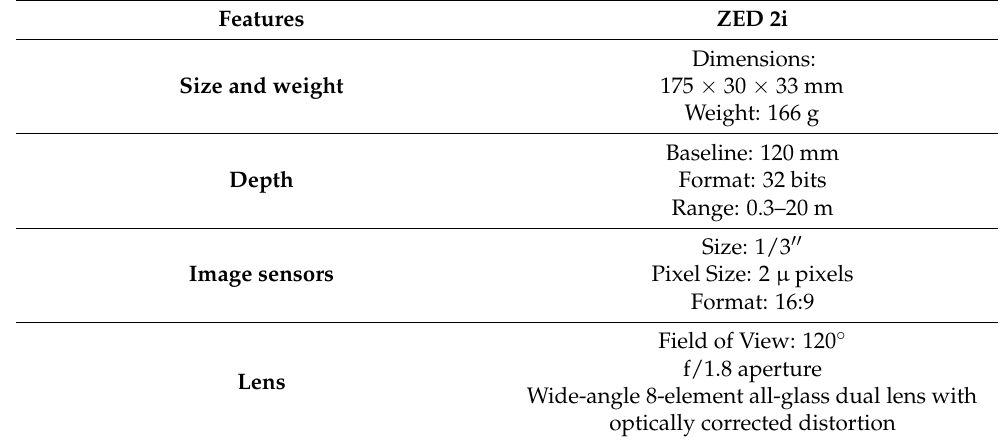
Table 2. Features of ZED 2i depth sensor (courtesy of Stereolabs)